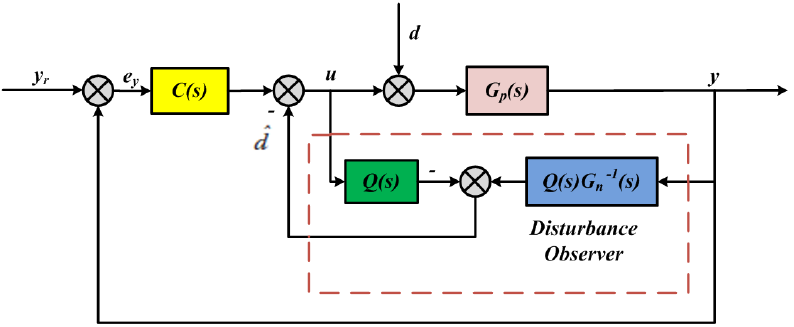
Figure 4. Conventional DOB